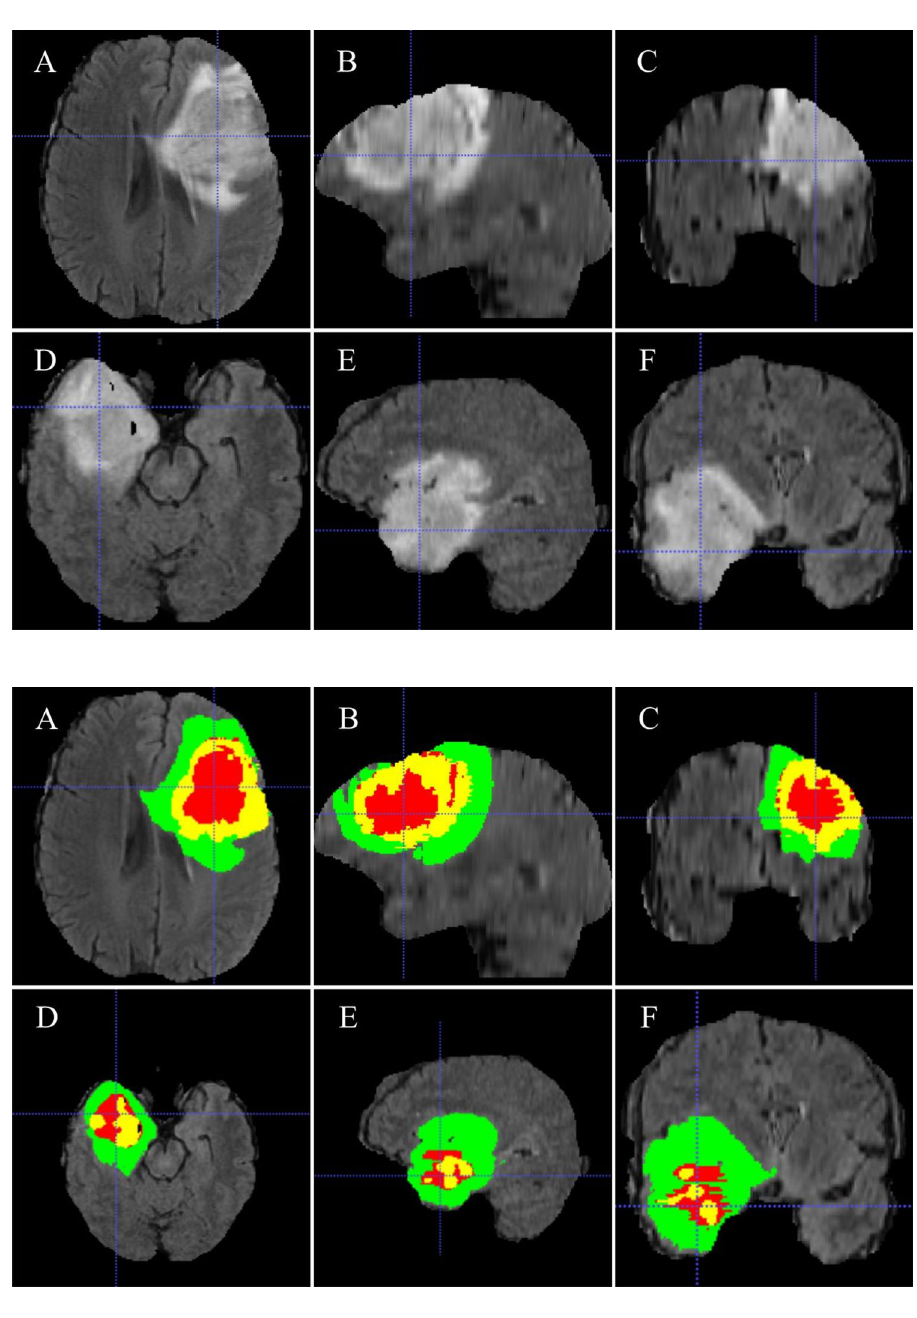
Fig. 2 Cases for glioma with different grades. The first row shows a FLAIR-based MRI for a patient with GBM from the a axial direction, b sagittal direction, and c coronal direc- tion. The second row shows a FLAIR-based MRI for a patient with LGG in the d axial direc- tion, e sagittal direction, and f coronal direction